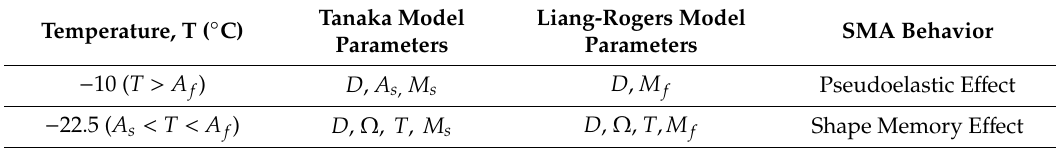
Table 5. Most influential parameters for Tanaka and Liang-Rogers